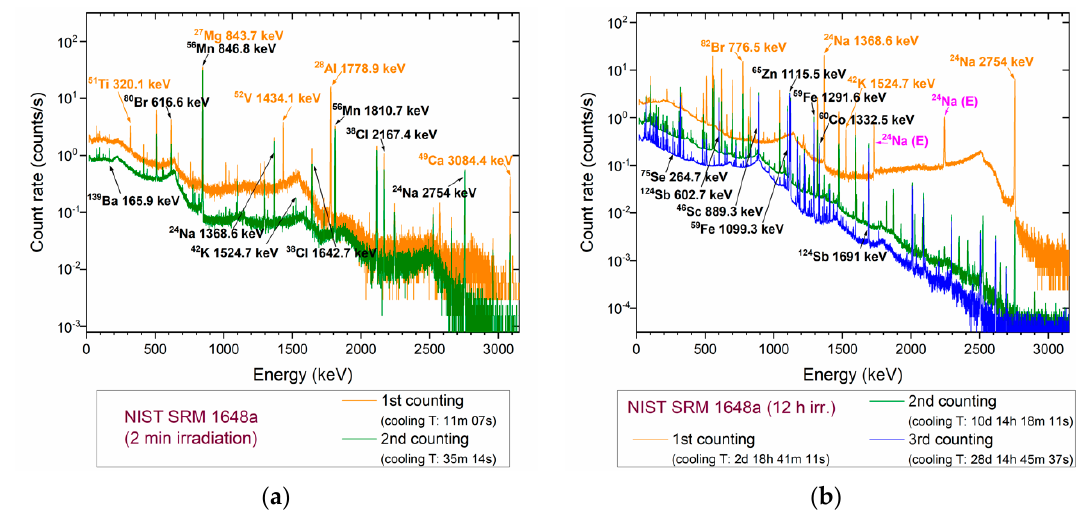
Figure 3. Gamma ‐ ray spectra of NIST SRM 1648a urban PM irradiated for ( a ) 2 min and ( b ) 12 h. Figure 3. Gamma-ray spectra of NIST SRM 1648a urban PM irradiated for ( a ) 2 min and ( b ) 12